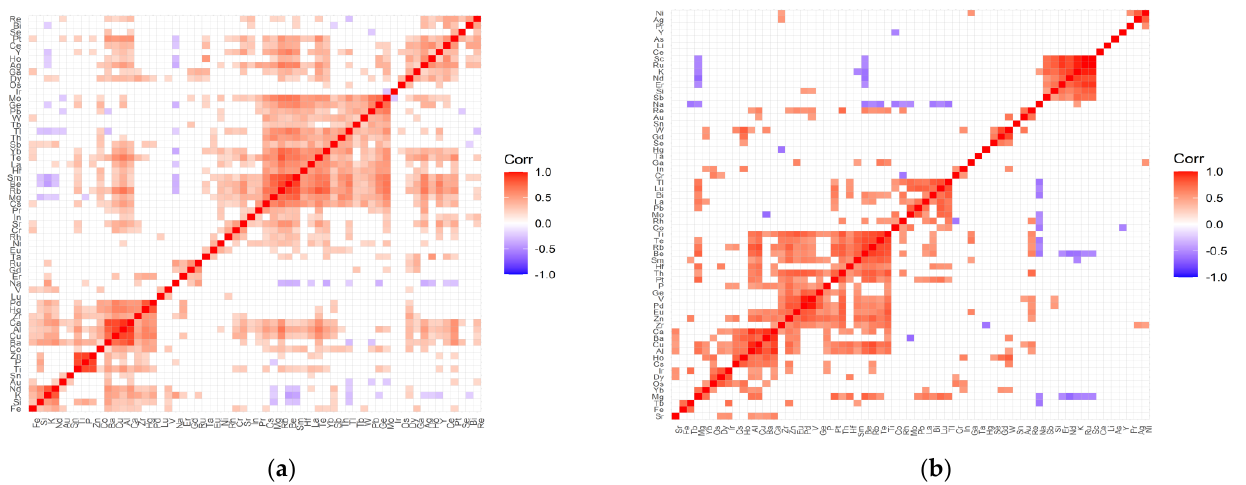
Figure 1. Correlation matrix for the control ( a ) and test ( b ) groups representing patients with cataract and coexisting AMD.